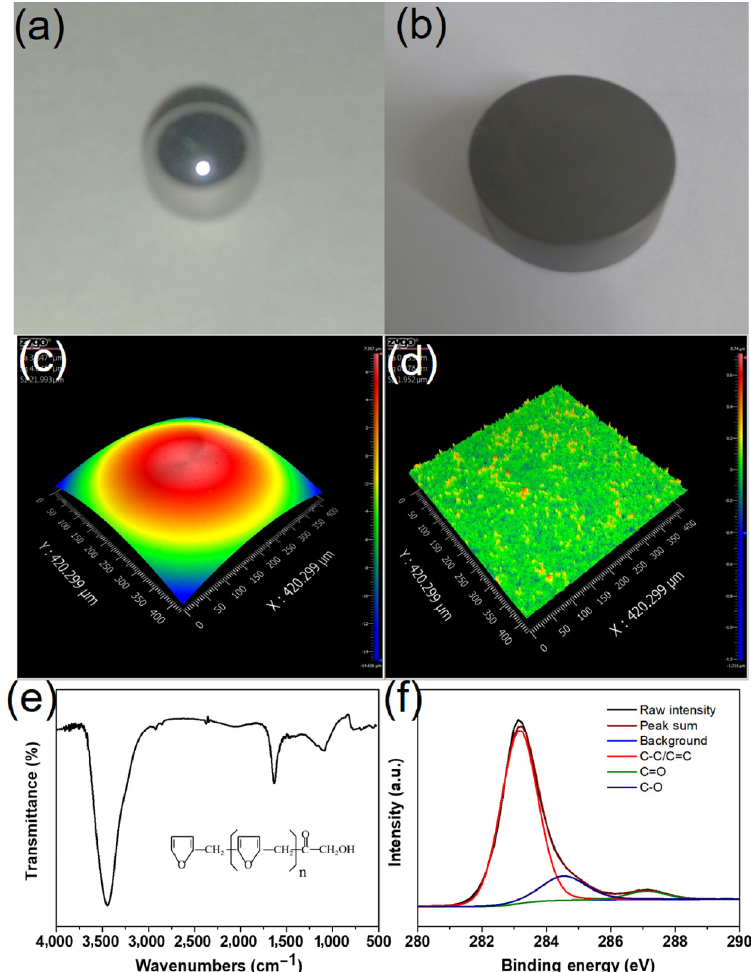
Fig. 2 Optical micrographs of cemented carbide ball (a) and impregnated graphite (b), three-dimensional topographies of the ball (c) and the impregnated graphite (d), FTIR (e), and XPS (f) spectra of impregnated graphite. The inset (e) displays the chemical formula of furan